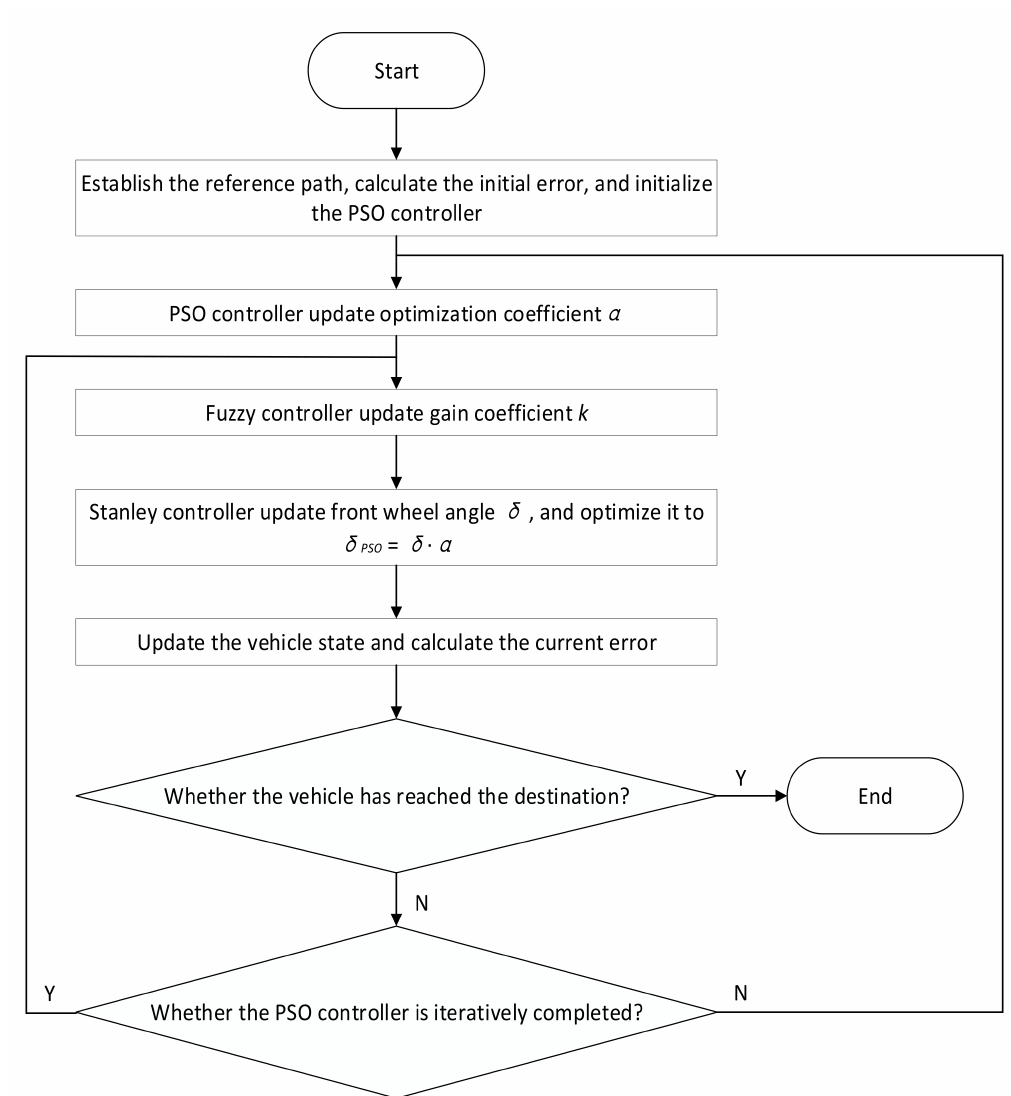
Figure 6. Flowchart of simulation